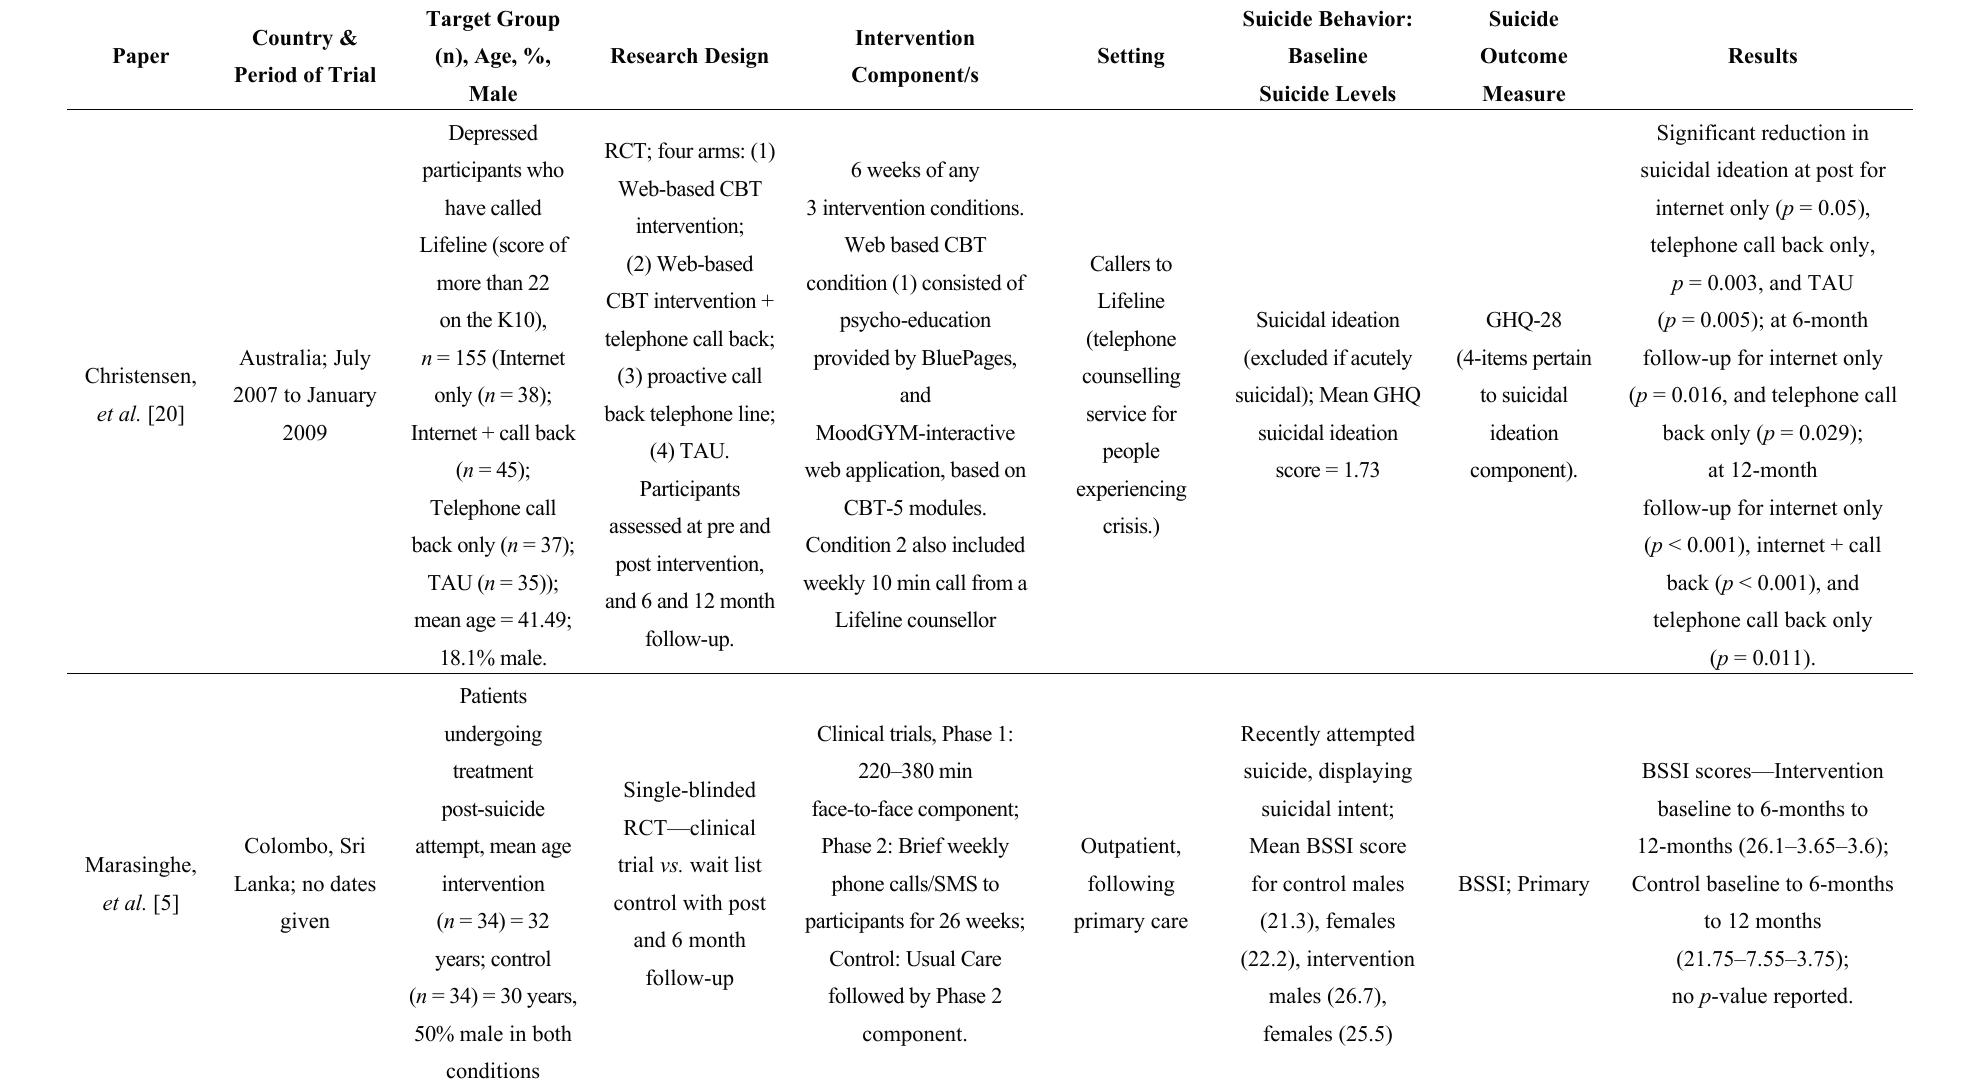
Table 2. Internet and mobile programs designed to assist those experiencing suicidal ideation or deliberate self-harm.